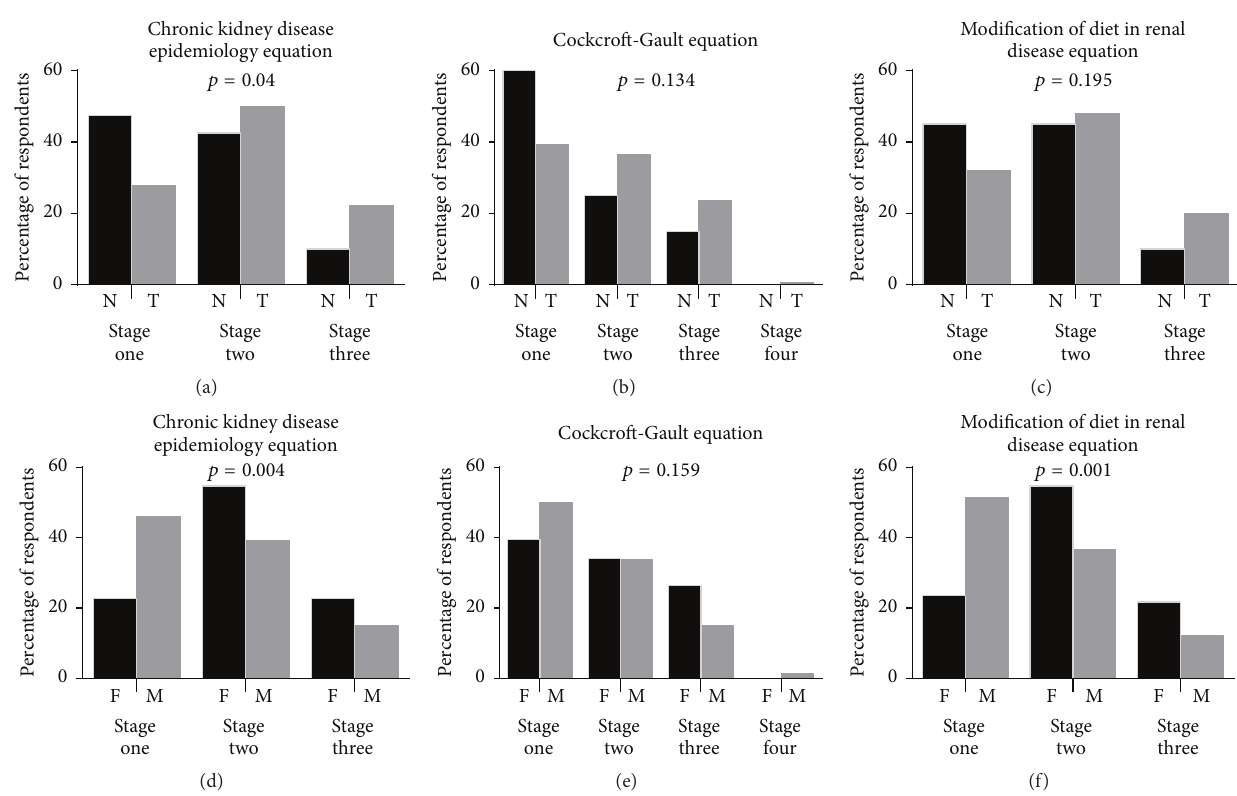
Figure 1: Estimates of the prevalence of CKD in the study population using the renal function equations stratified by therapy and gender. N: drug na¨ıve, T: therapy, F: female, and M: